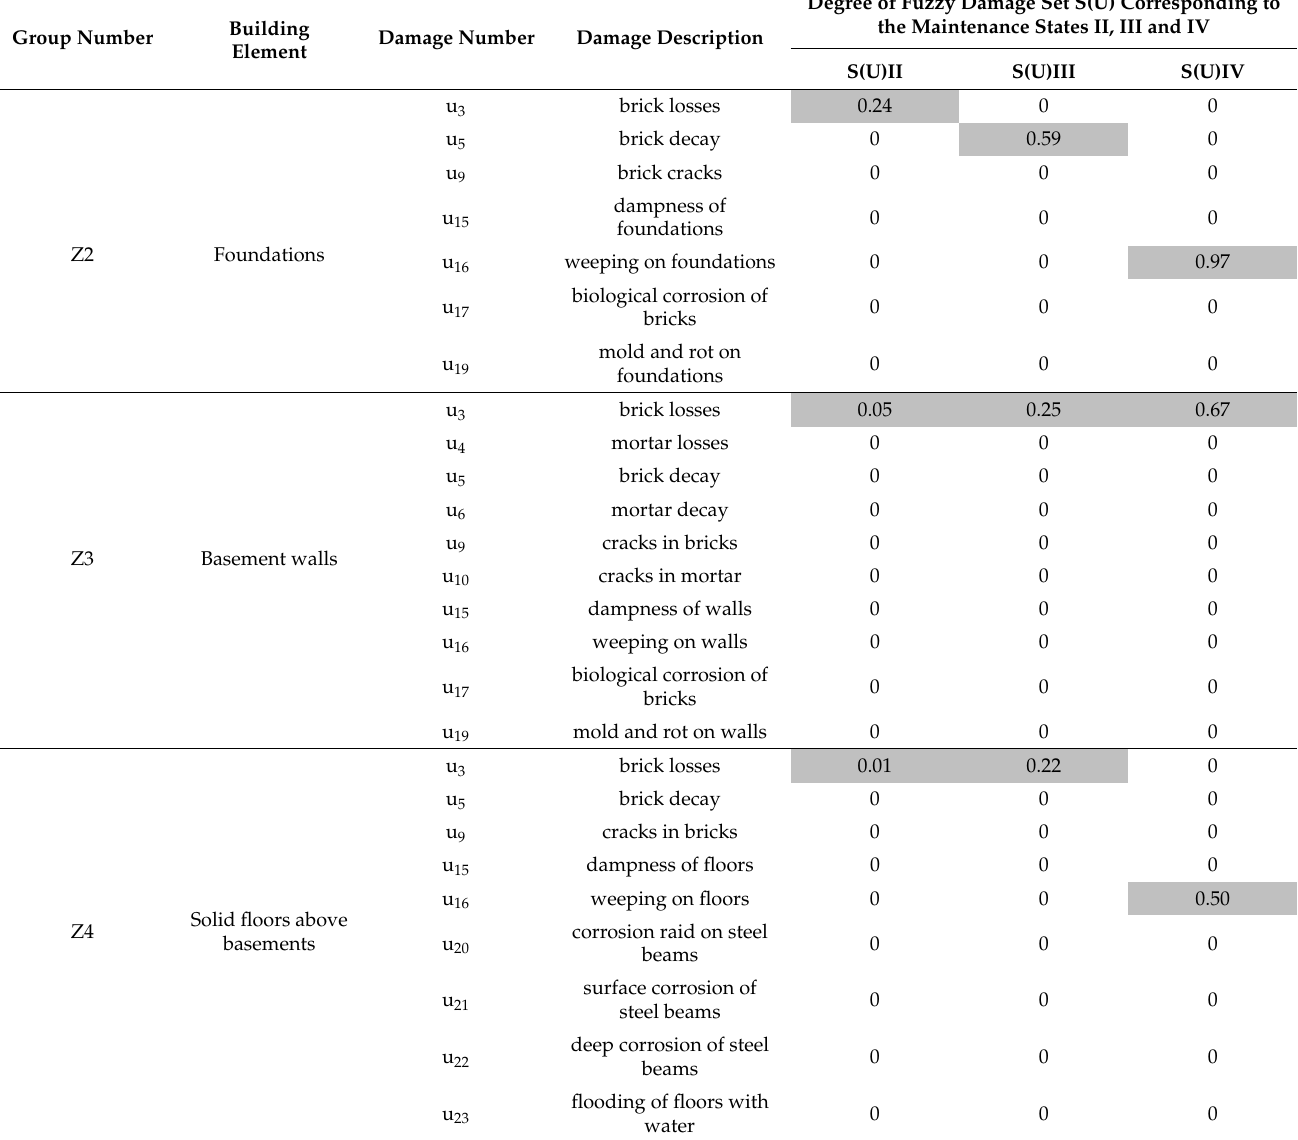
Table 1. The degree of fuzzy damage to building elements in their middle maintenance states. (grey backgroud is necessary to distinguish extreme values)